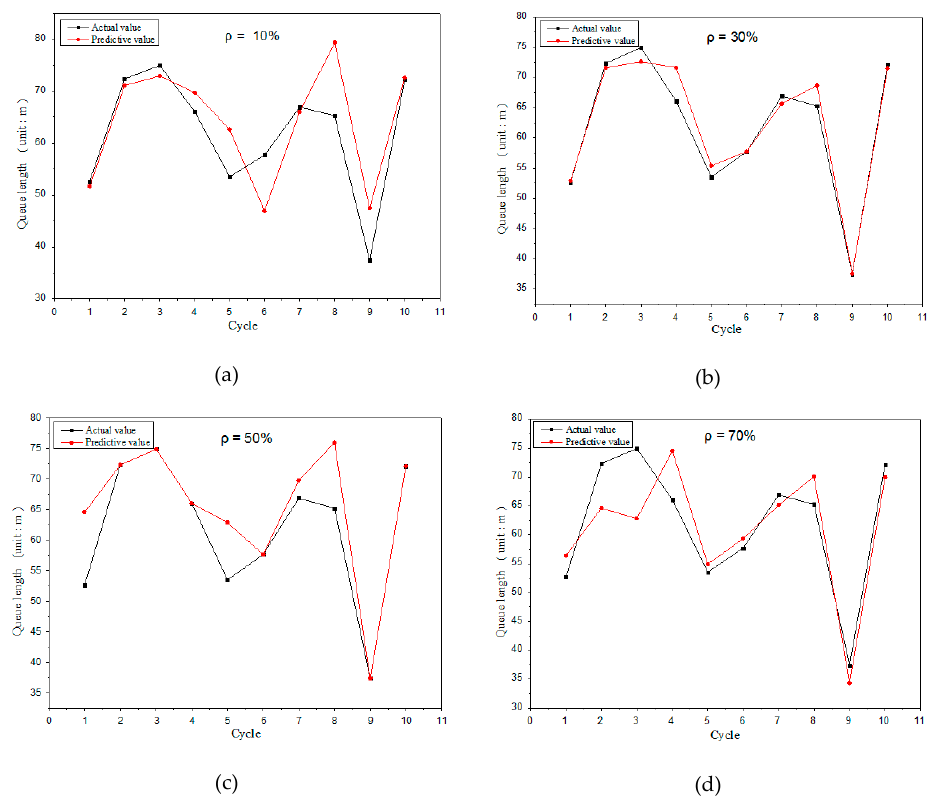
Figure 9. Queue length at 10% penetration rate ( a ) and queue length at 30% penetration rate ( b ) and queue length at 50% penetration rate ( c ) and queue length at 70% penetration rate ( d ) .